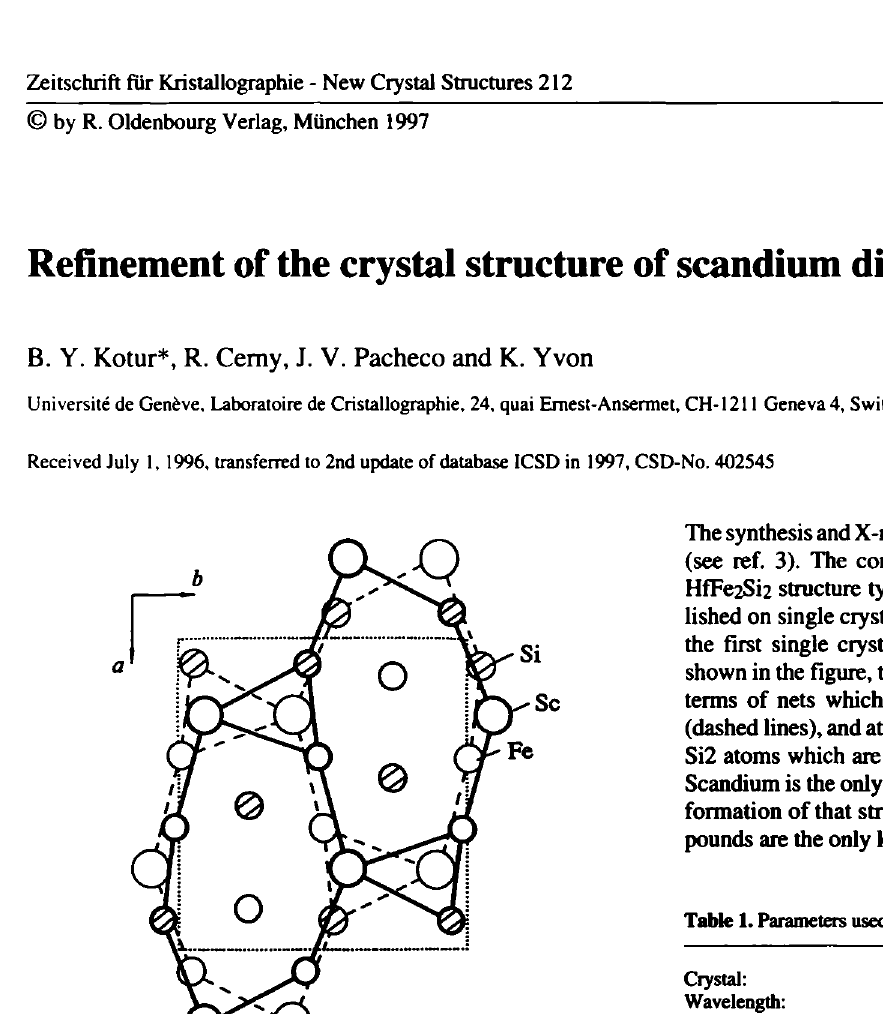
Table 1. Parameters used for the X-ray data collection